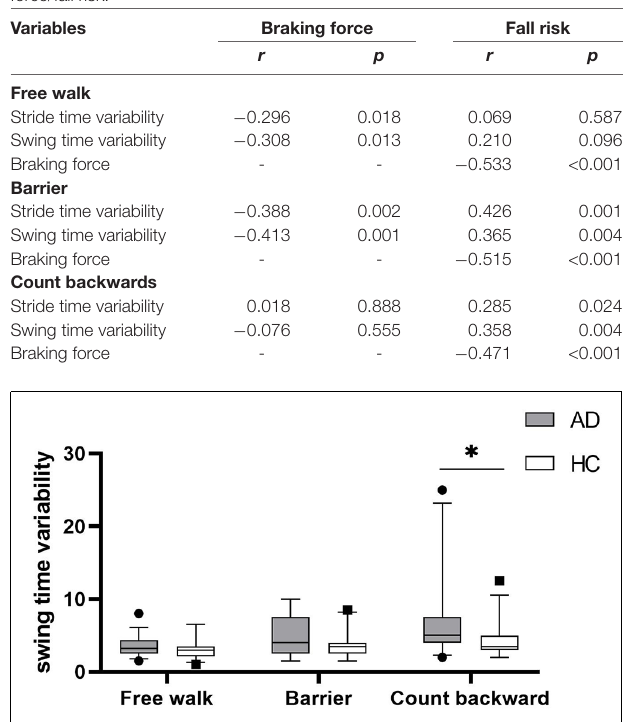
FIGURE 4 | The comparison of swing time variability between patients with AD and HCs in the walking of Free walk, Barrier, and Count backward. ∗ P <